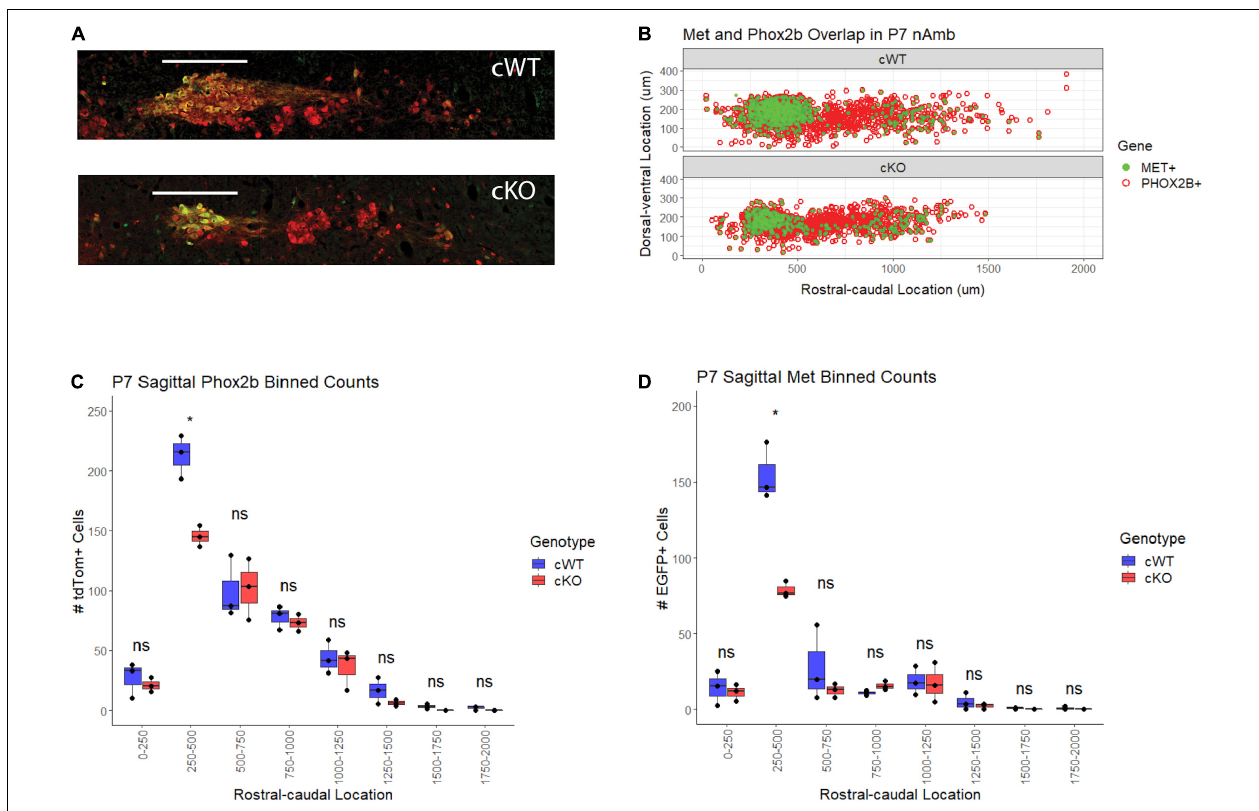
FIGURE 4 | Topology of MET-EGFP expression and motor neuron loss in the nAmb following conditional deletion of Met . (A) Single-section representation of Phox2b + and MET + motor neuron topology in the nAmb. (B) Comparative topology of tdTom (Phox2b) and EGFP (MET) positive nAmb motor neurons. n = 3 per genotype. (C) Binned Abercrombie-corrected counts of TdTom + cells denoting Phox2b + motor neurons in nAmb of cWT and cKO mice. n = 3 per genotype. t -test, “*” indicates p ≤ 0.05. (D) Binned Abercrombie-corrected counts of GFP + cells denoting MET + motor neurons in nAmb of WT and cKO mice. n = 3 per genotype. t -test, p ≤ 0.05. Scale bars = 250 µ m. The brightness and contrast of each channel was adjusted separately for visualization purposes.